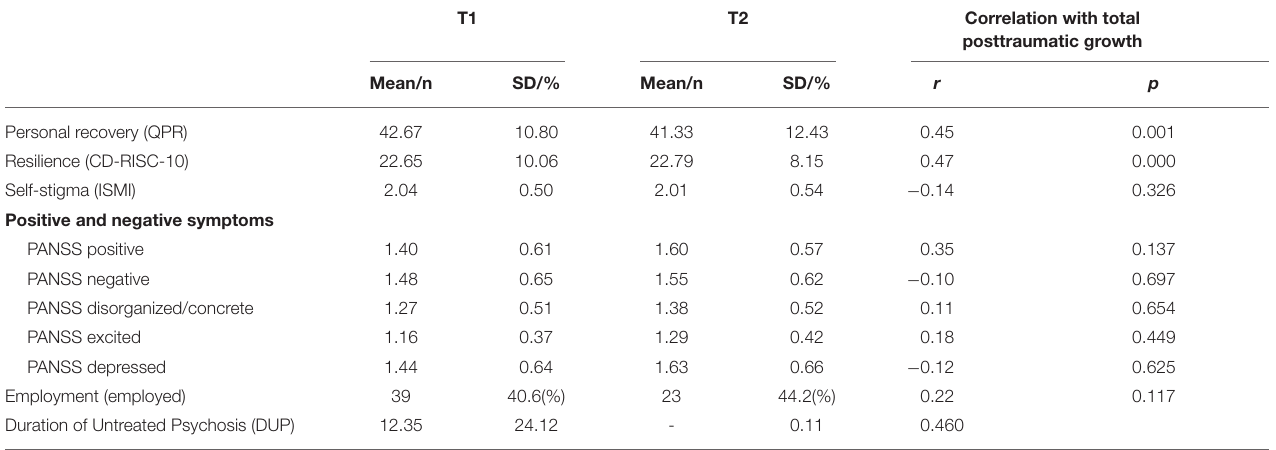
TABLE 3 | Factors associated with PTGI scores in respondents. T1 T2 Correlation with total Mean/n SD/%